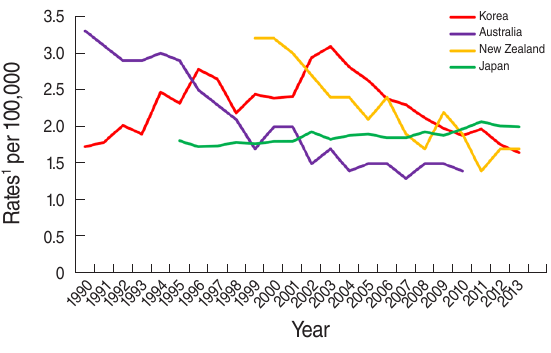
Figure 5. Trends of mortality rates of cervical cancer, worldwide, 1990-2013. Source from Korean Statistical Information Service. Death causes by 5-year age group and gender, mortality rates 1983-2013; 2014 [13]; Ministry of Health. Cancer: historical sum- mary 1948-2011; 2014 [21]; Australian Institute of Health and Wel- fare. Australian cancer incidence and mortality (ACIM) book for cervical cancer; 2014 [22]; Japan National Cancer Center. Cancer mortality from vital statistic in Japan 1958-2013; 2014 [23]. 1 Age- adjusted to World Health Organization world standard population.